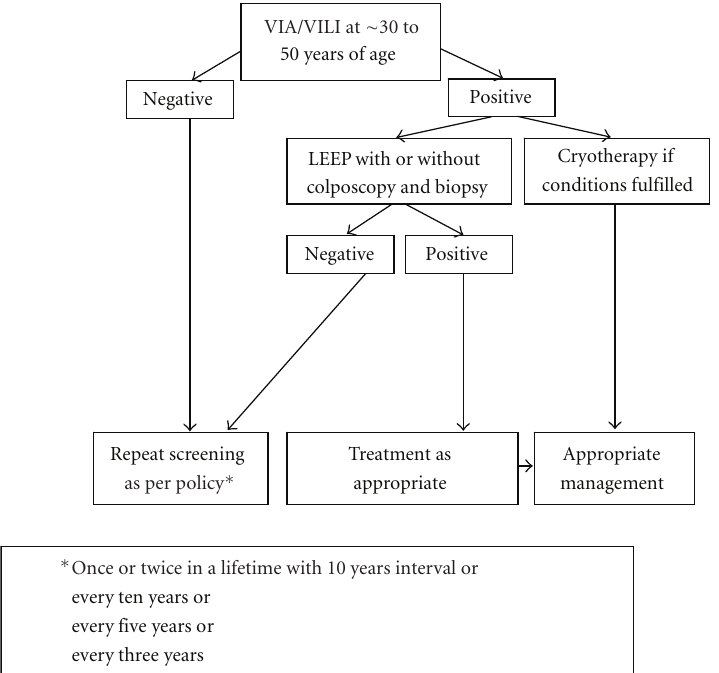
Figure 2: Schema for low-resource situations starting with VIA-based screening.